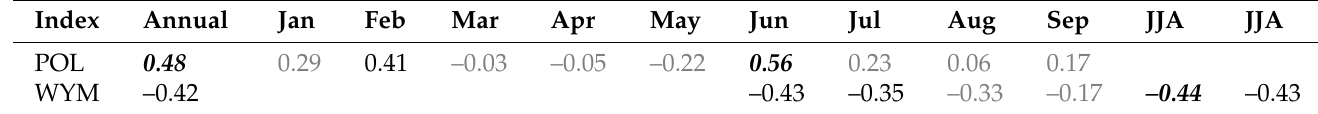
Table 5. Spearman’s rank correlation coefficient between the annual glacier-wide climatic mass balance and the Po- lar/Eurasia index (POL) and the Webster and Yang Monsoon index (WYM). Empty cells mark months or seasons when the index does not exist. Grey coefficients are not significant, normal font denotes significance level 0.05 and bold and italic fonts significance level